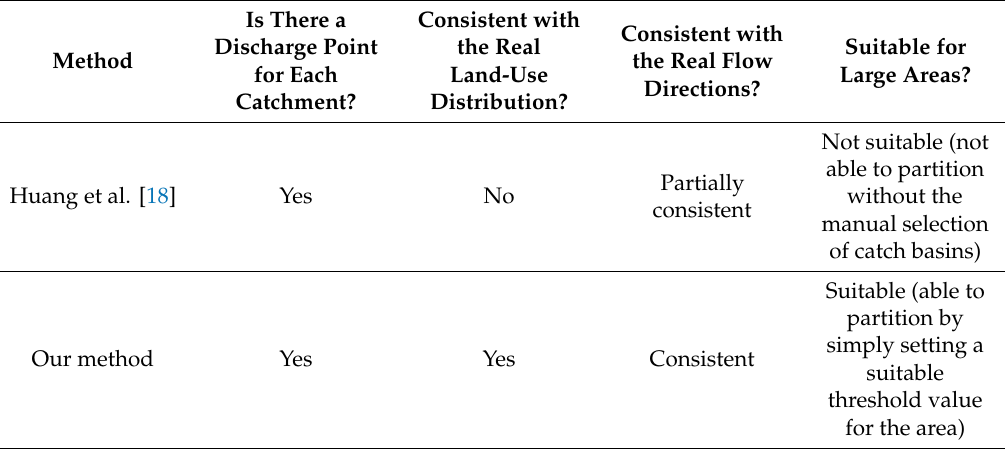
Table 1. Comparison between the two catchment division methods.